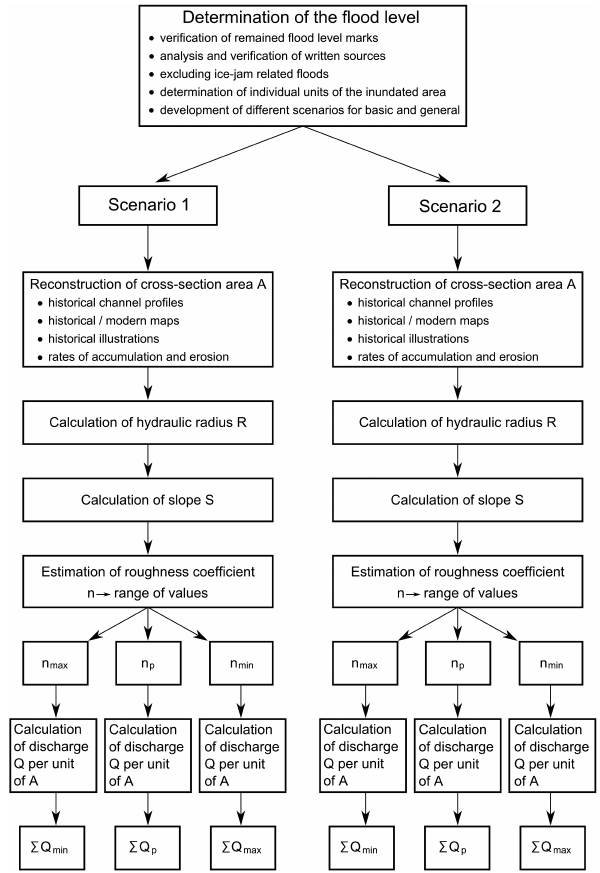
Figure 3. Scheme of discharge calculation and main aspects of pa- rameter